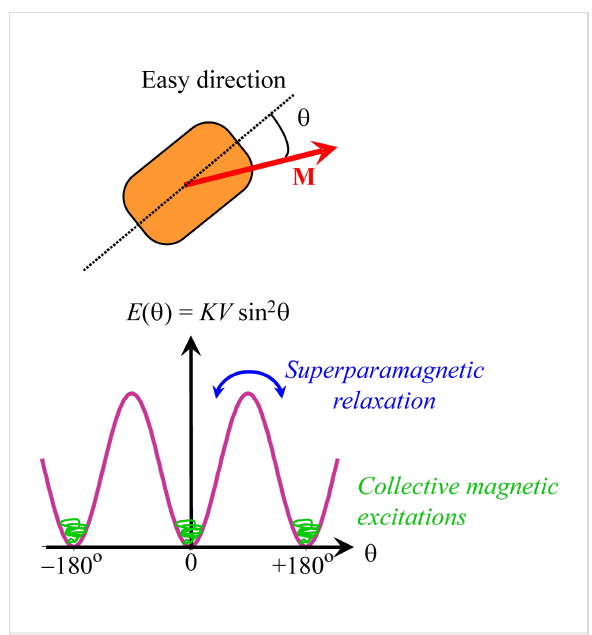
Figure 1: Schematic illustration of magnetic fluctuations in a nanopar- ticle. At low temperatures the direction of the magnetization vector M fluctuates near one of the easy directions (collective magnetic ex- citations). At higher temperatures the thermal energy can be compa- rable to the height, KV , of the energy barrier separating the easy direc- tions, and the magnetization can fluctuate between the easy directions (superparamagnetic